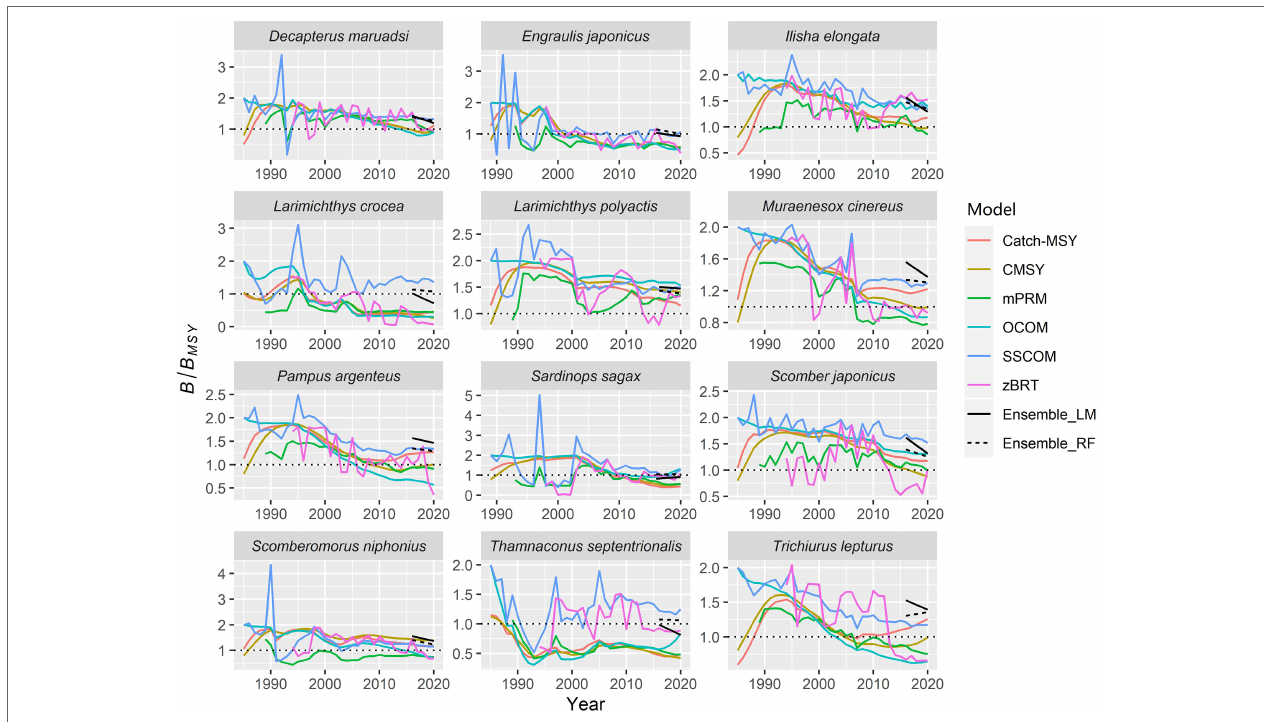
FIGURE 6 | Time trajectories of B/B MSY estimates of individual and ensemble COMs for the stocks of ECS. The horizontal dotted line indicates B equals to B MSY